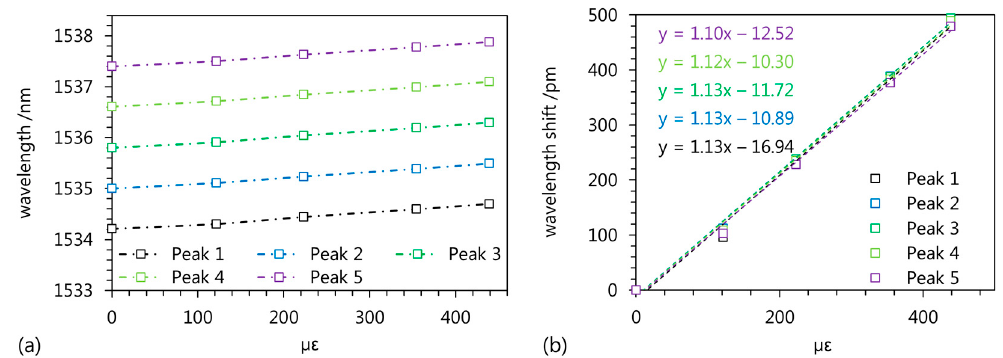
Figure 6. ( a ) Spectral position and ( b ) relative wavelength shift of the five reflected wavelength peaks of the superstructure PPBG during tensile strain.